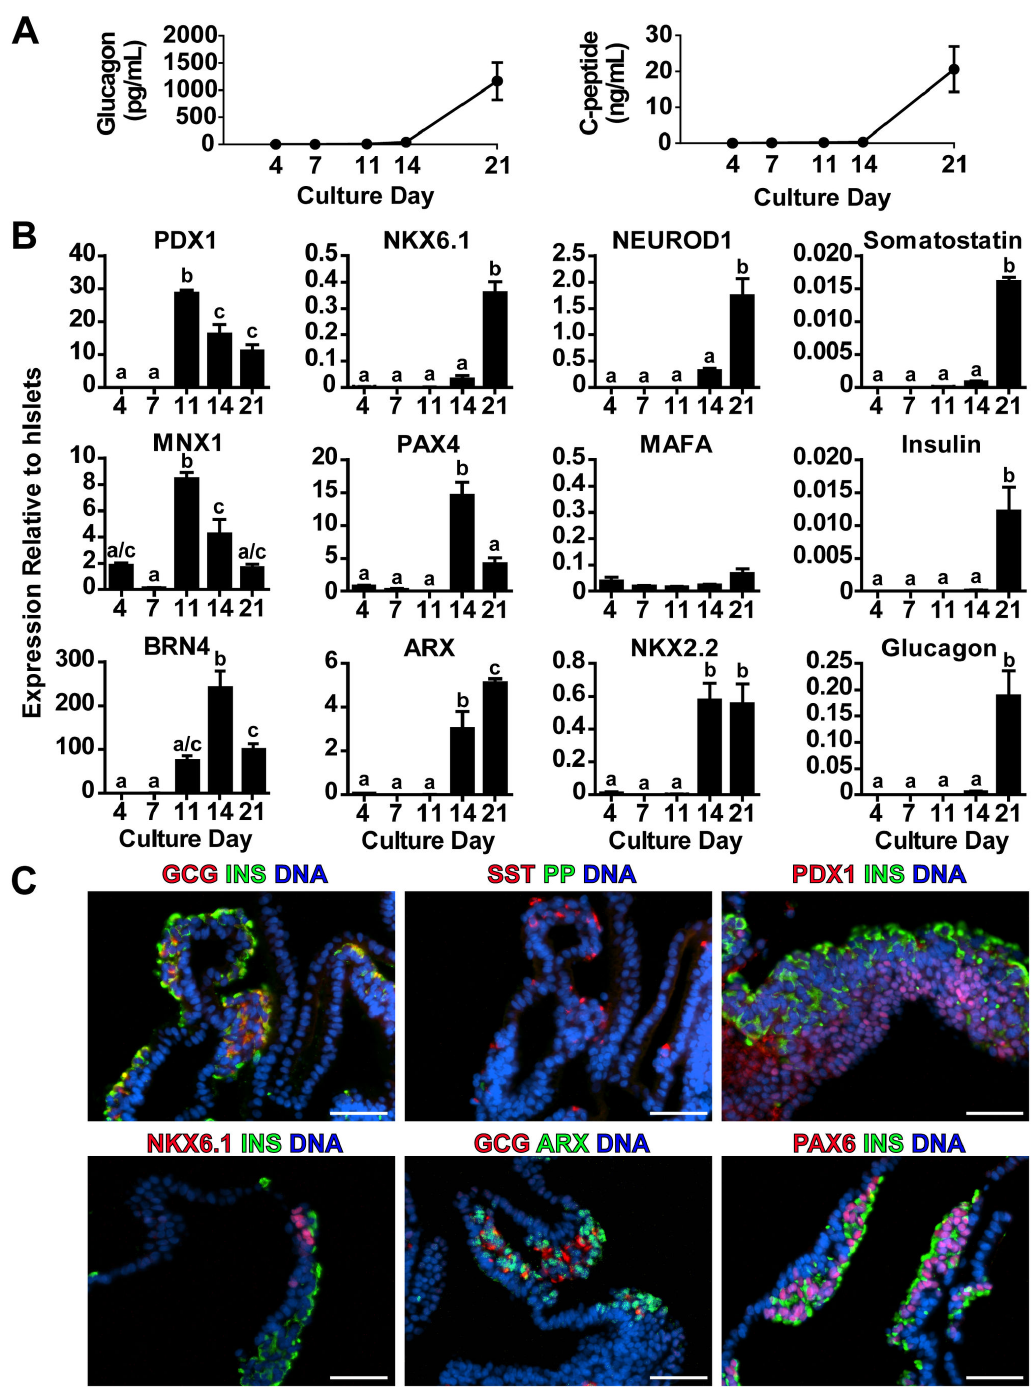
Figure 5. High Seeding Density Cultures Follow Expected Endocrine Developmental Timeline. (A) Media samples from multiple (N=12) high hESC cell seeding density differentiations contain reproducibly high levels of C-peptide and glucagon as measured by radioimmunoassay. (B) Over the differentiation time course expression of transcription factors and islet hormones was examined by RT-qPCR relative to adult human islet expression levels. (C) 21 day differentiated hESCs were immunostained as agarose-embedded, paraffinized sections for pancreatic hormones and key transcription factors involved in pancreatic endocrine induction and maturation. * represents p<0.05 comparing day 14 and 21 media content. Different superscripts (a, b, c) are significantly different from each other within each graph by one-way ANOVA with Bonferroni post-hoc test. Scale bars are 50 μm. doi: 10.1371/journal.pone.0082076.g005 PLOS ONE |